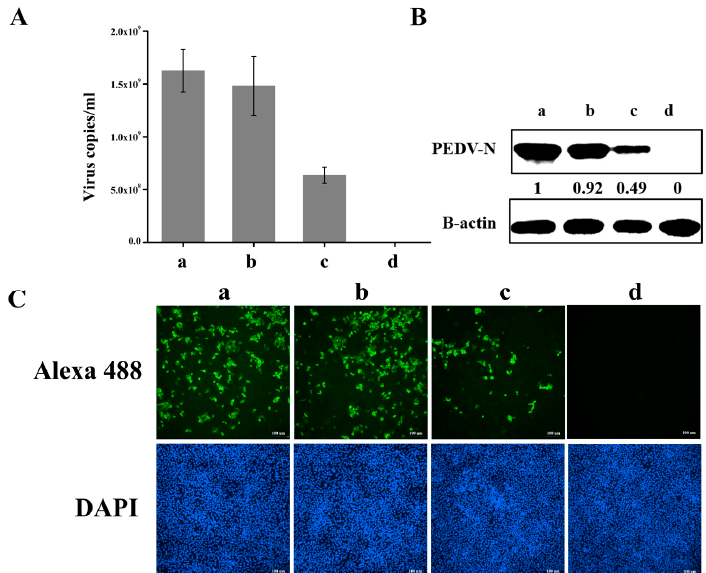
Figure 7. Knockdown of hnRNP A1 expression inhibits CV777 replication. CCL-81 cells were transfected without siRNA (a) or with NC (b) or siRNA-1 (c). At 60 hpt, cells were infected with CV777 Strain at a moi of 0.001 or mock infected (d). Virus suspensions were harvested at 24 hpi to calculate the virus titer by real-time RT-PCR. The virus copies per mL suspension was calculated ( A ). Cells were harvested at 24 hpi to analyze the expression of PEDV N protein by western blot ( B ) and the numbers of cells infected with PEDV by IFA (Original magnification 100 × ) ( C ). PEDV N protein levels were quantified by measuring band intensities and normalized with respect to the amount of β -actin. Data are shown as means ± the SEM of at least three independent experiments, with the error bars representing the standard deviations.